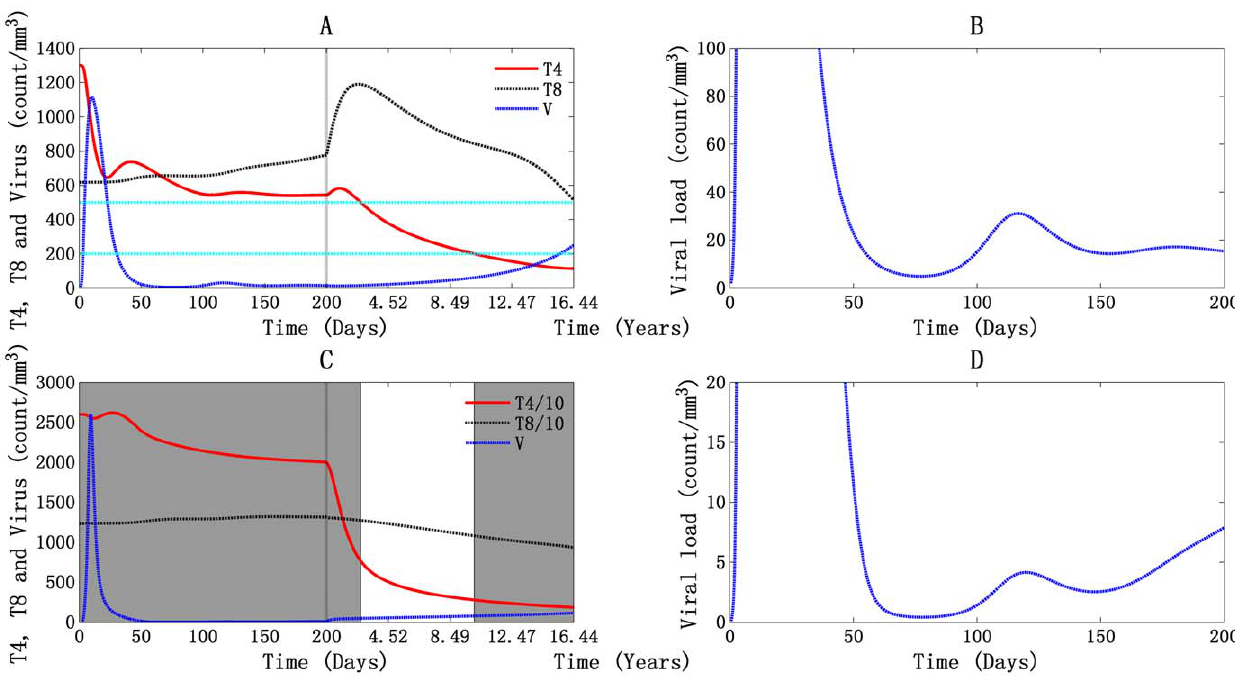
Figure 1. Global simulation of HIV-1 infection dynamic: T4, T8, and viral particles. A and B represent the situation in PB, and C and D represent it in LNs. The double green horizontal lines in panel A represent the T4 cell counts at 500 cells/mm 3 and 200 cells/mm 3 , which are the time points for LNs stages classification (expressed as shadowed parts for stage 1 and stage 3 in panel C). AIDS occurs at about 3668 days, about 10 years.